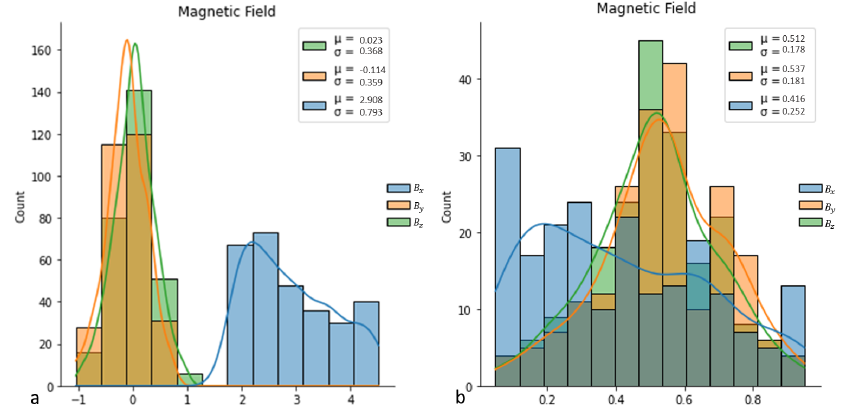
Figure 12. ( a ) Original data . ( b ) Normalized data.